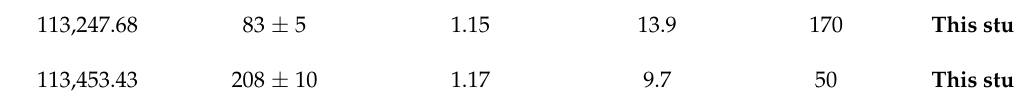
Table 2. Steady-state kinetic parameters of known D2HGDHs toward D-2-HGA. Enzyme Family